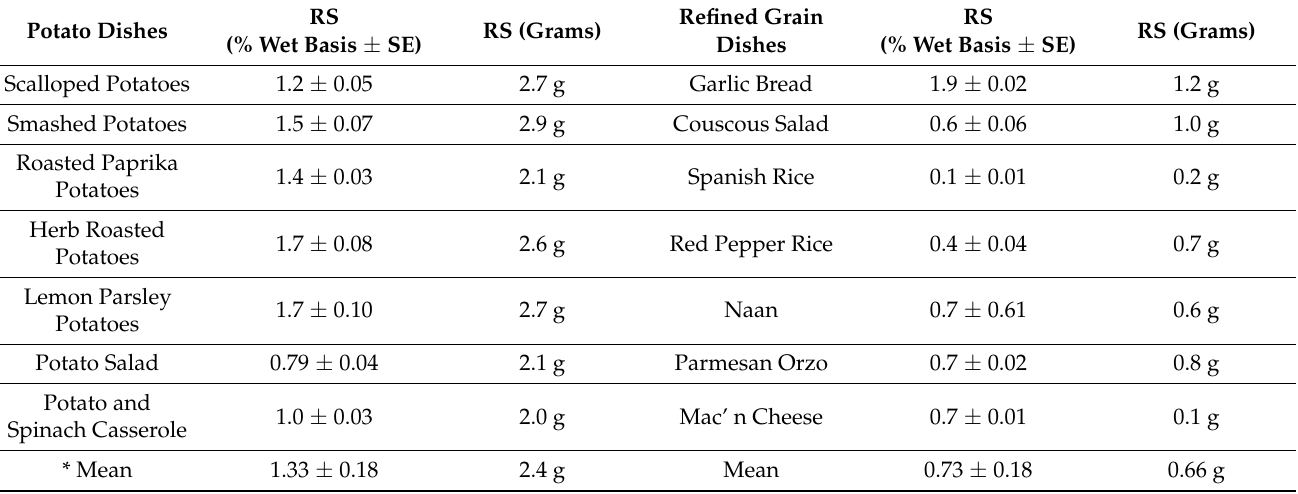
Table 1. Resistant starch content of the study